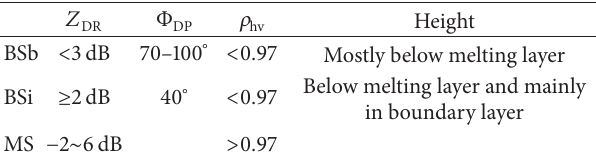
Table 3: Typical ranges of 𝑍 and